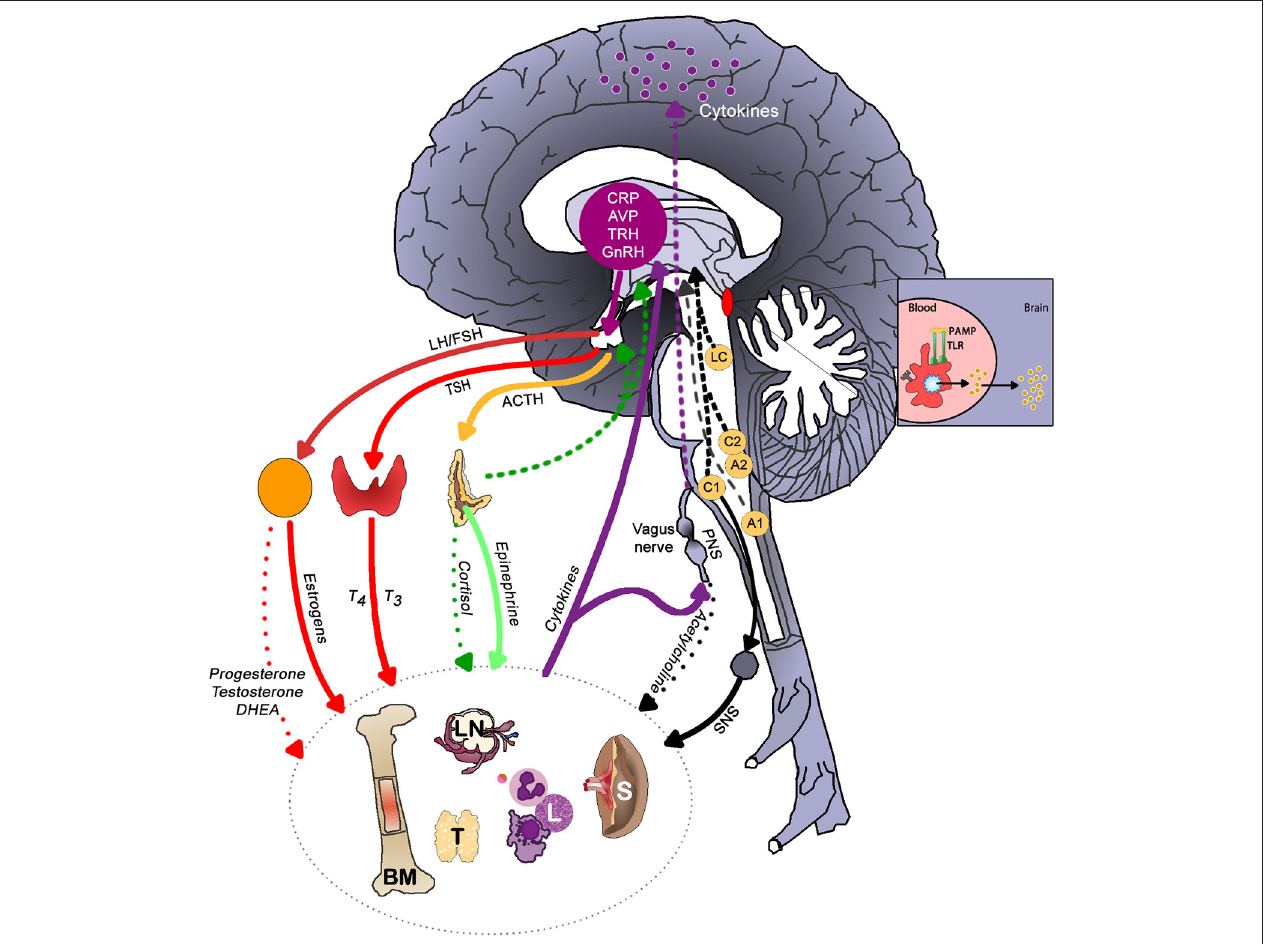
FIGURE 3 | The main brain-immune system pathways and feedback loops illustrating the interconnected effects of physical and emotional stress in health. Sympathetic nervous system (SNS) activation facilitates immune cell activity and systemic immune responses, while the parasympathetic nervous system (PNS) and the hypothalamic-pituitary-adrenal (HPA) axis generally inhibit inflammatory responses. In a well-regulated system, cortisol provides negative feedback to the HPA axis. Chronic activation of the stress response systems can lead to excessive immune cell activity and promote system inflammation due to the reduced activity of cholinergic anti-inflammatory pathway and development of glucocorticoid insensitivity. Cytokines regulate autonomic nervous system function and the HPA axis as well as induce sickness behaviors. The brain receives information about systemic inflammation levels via the afferent vagal nerve and “leaky” portions of the blood brain barrier especially near the circumventricular organs and these messages influence cytokine production within the brain. Often elevated systemic inflammation increases glia production of cytokines. CRP, C-reactive protein; AVP, arginine vasopressin; TRH, thyrotropin-releasing hormone; GnRH, gonadotrophin-releasing hormone; LH, luteinizing hormone; FSH, follicle stimulating hormone; TSH, thyroid stimulating hormone; PAMP, pathogen-associated molecular pattern; TLR, toll-like receptor; LC, locus coeruleus; C1 & C2, adrenergic cell groups in brainstem; A1& A2, noradrenergic cell groups in brainstem; T4, tetraiodothyronine; T3, triioidothyronine;